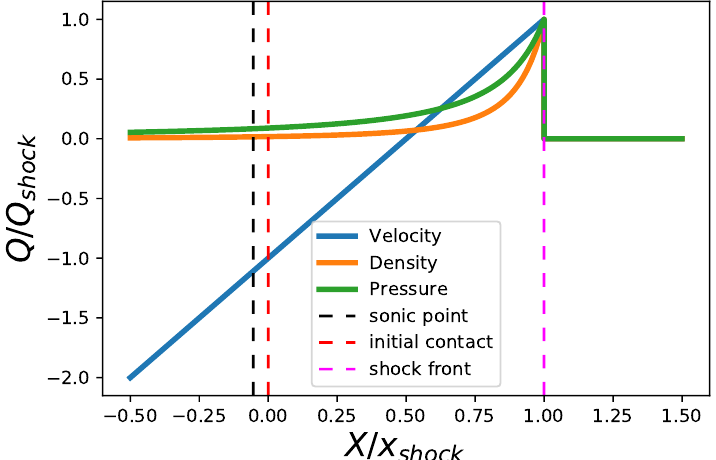
Figure 5. Normalized velocity, density and pressure around the shock region. The shock front, sonic point and initial contact location are